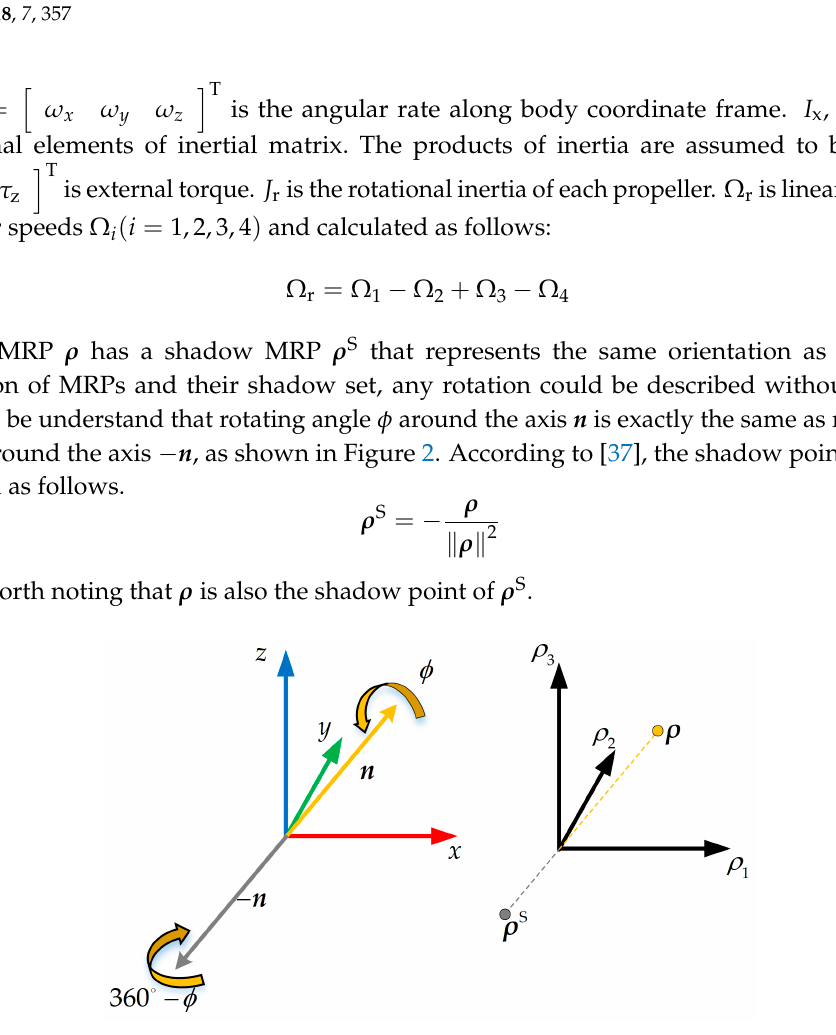
Figure 2. Graphic representation of original modified Rodrigues parameter (MRP) and shadow MRP